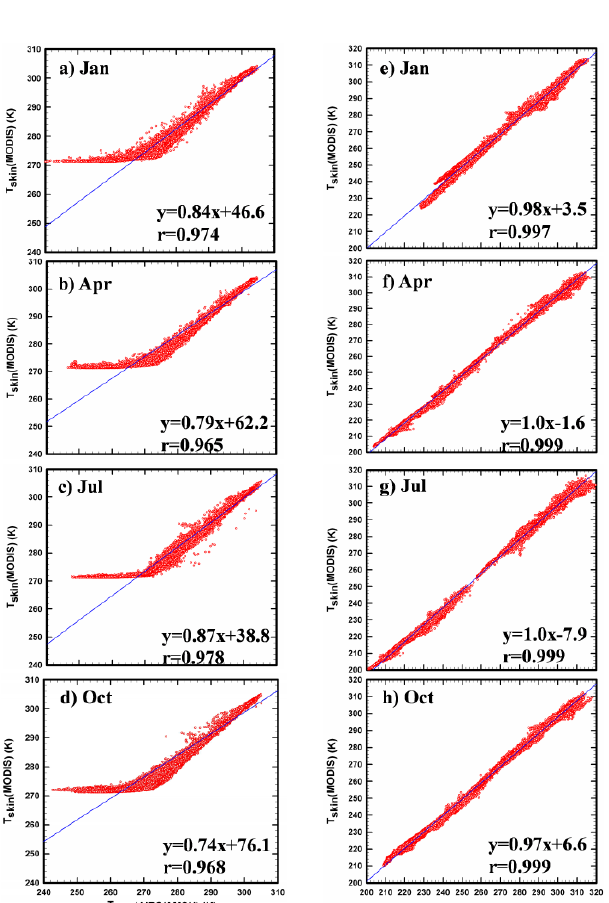
Fig. 5. Scatter diagrams in climatological monthly mean values (K) of T skin (MODIS) versus T skin (AIRS/AMSU) over the global ocean in (a) January, (b) April, (c) July, and (d) October. Figure 5e– h are the same as Fig. 5a–d, but for global land. The values of AIRS/AMSU and MODIS have been examined in a grid box of 1 ◦ × 1 ◦ during the period from September 2002 to August